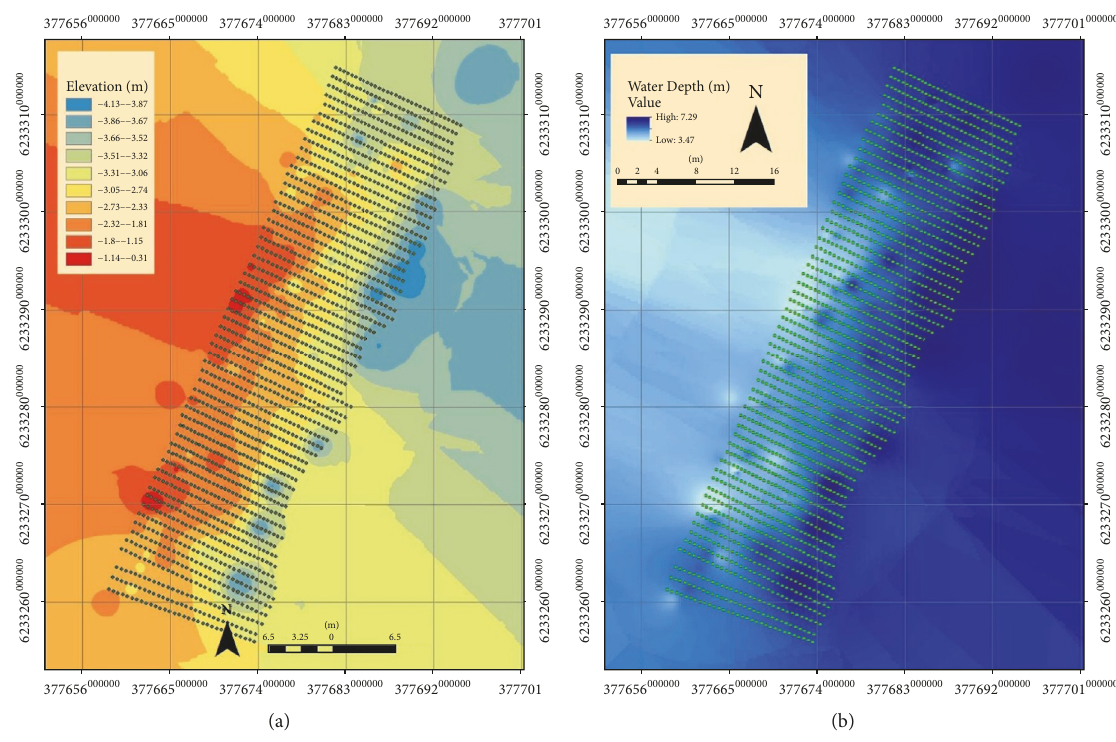
Figure 8: Elevation (a) and bathymetry (b) model. The dots represent the electrode